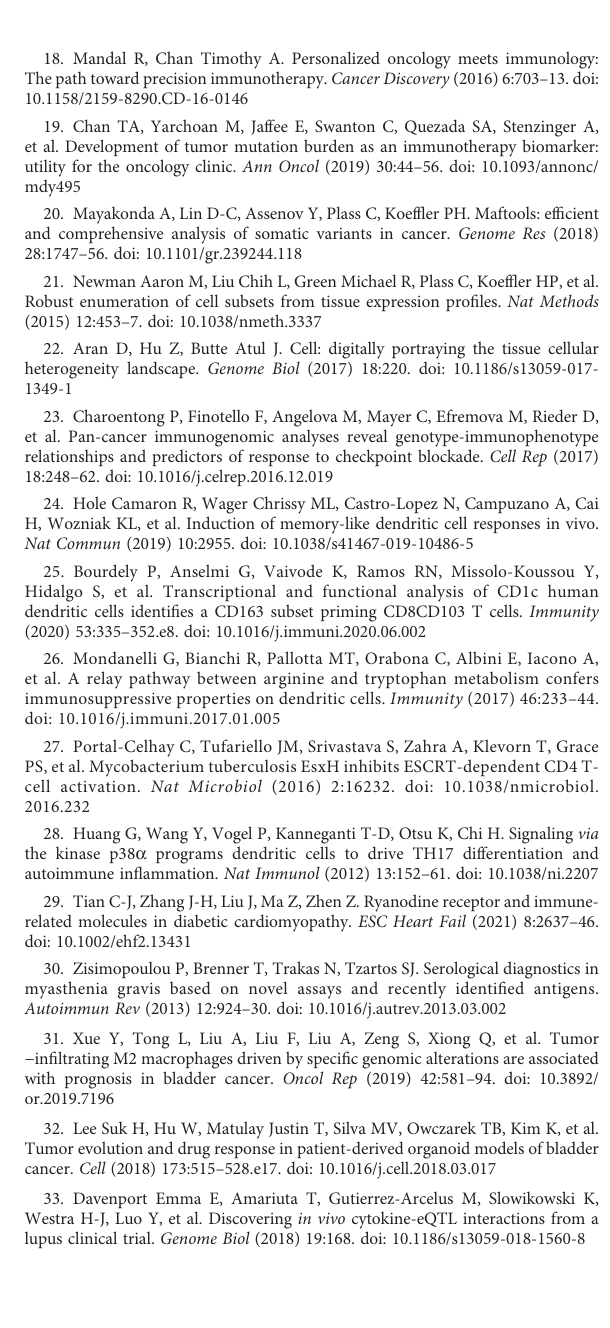
(LASSO) Cox regression for the DC-related key differentially expressed genes. (G) Immune cell abundance ratios in the BLCA cohorts. Each